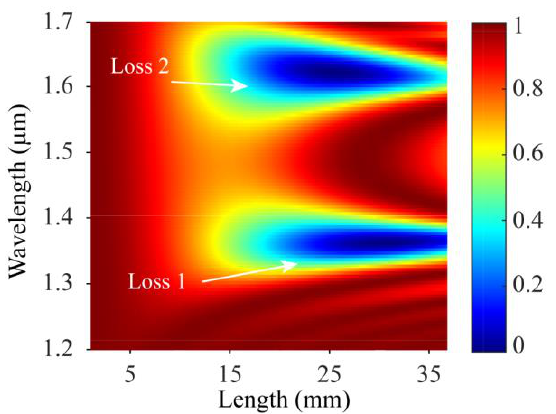
Figure 4. The energy distribution of the core mode of SMF-HLPG in the wavelength range of 1.2–1.7 µm.